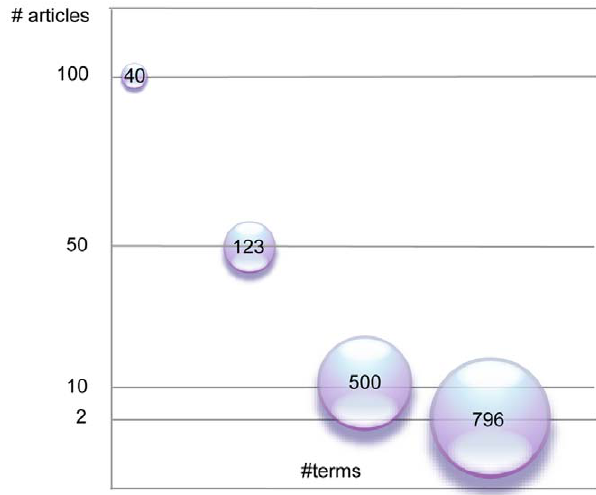
Figure 3. The number of characters (terms) present in at least 2, 10, 50, and 100 articles.